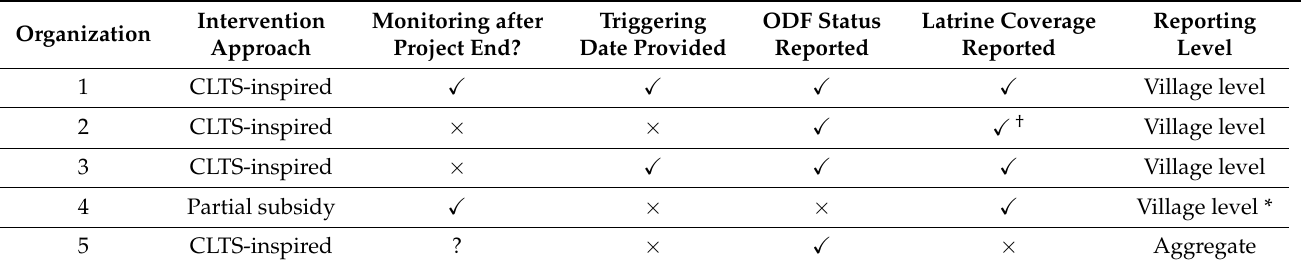
Table 1. Summary of monitoring and evaluation data submitted by each water, sanitation, and hygiene (WASH) agency.